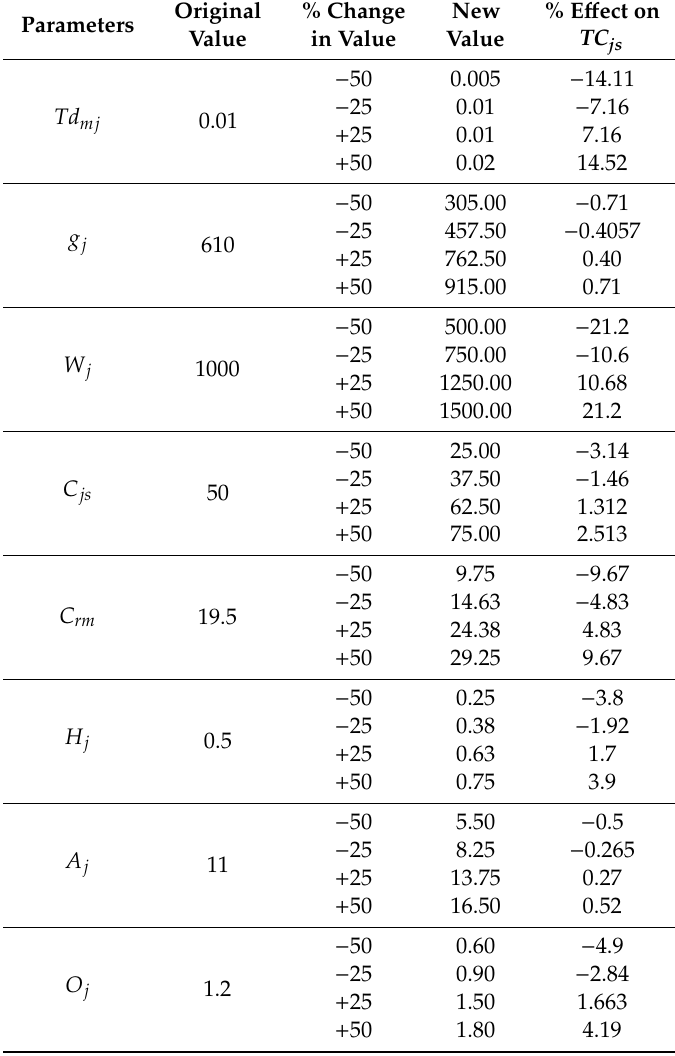
Table 5. Sensitivity analysis of the SCM with respect to key